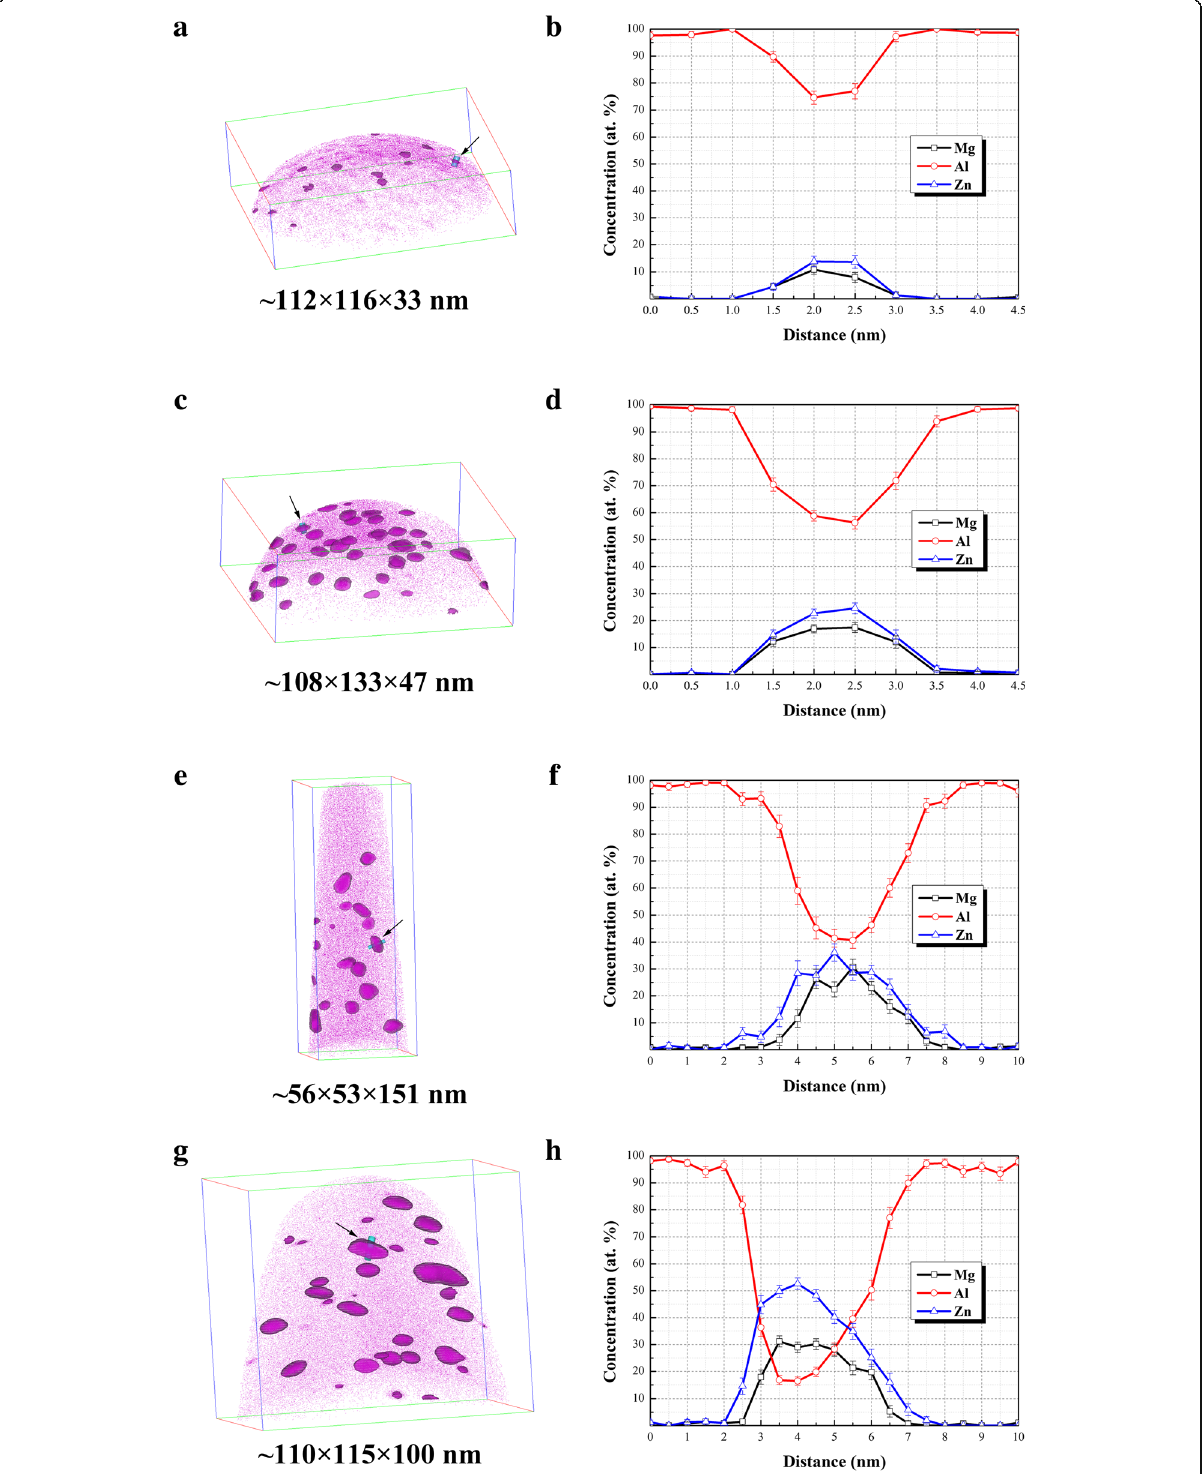
Fig. 3 Three-dimensional reconstruction of specimens in different second-stage aging states: a UA, c PAI, e PAII, and g OA. The composition profiles through marked typical nanoparticles in a , c , e , and g were measured using a selected cylinder (diameter, 3 nm) with a moving step of 0.5 nm and shown in b , d , f , and h ,